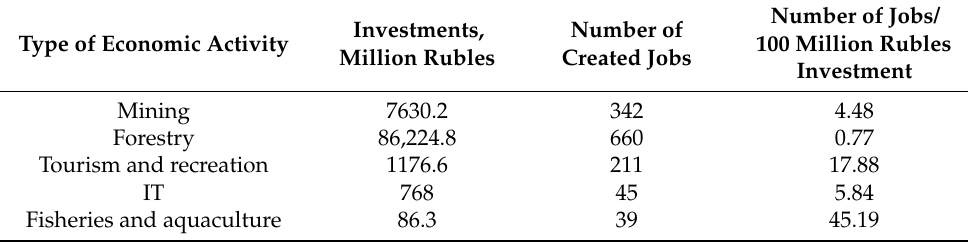
Table 1. Evaluation of economic activities by contribution to employment and